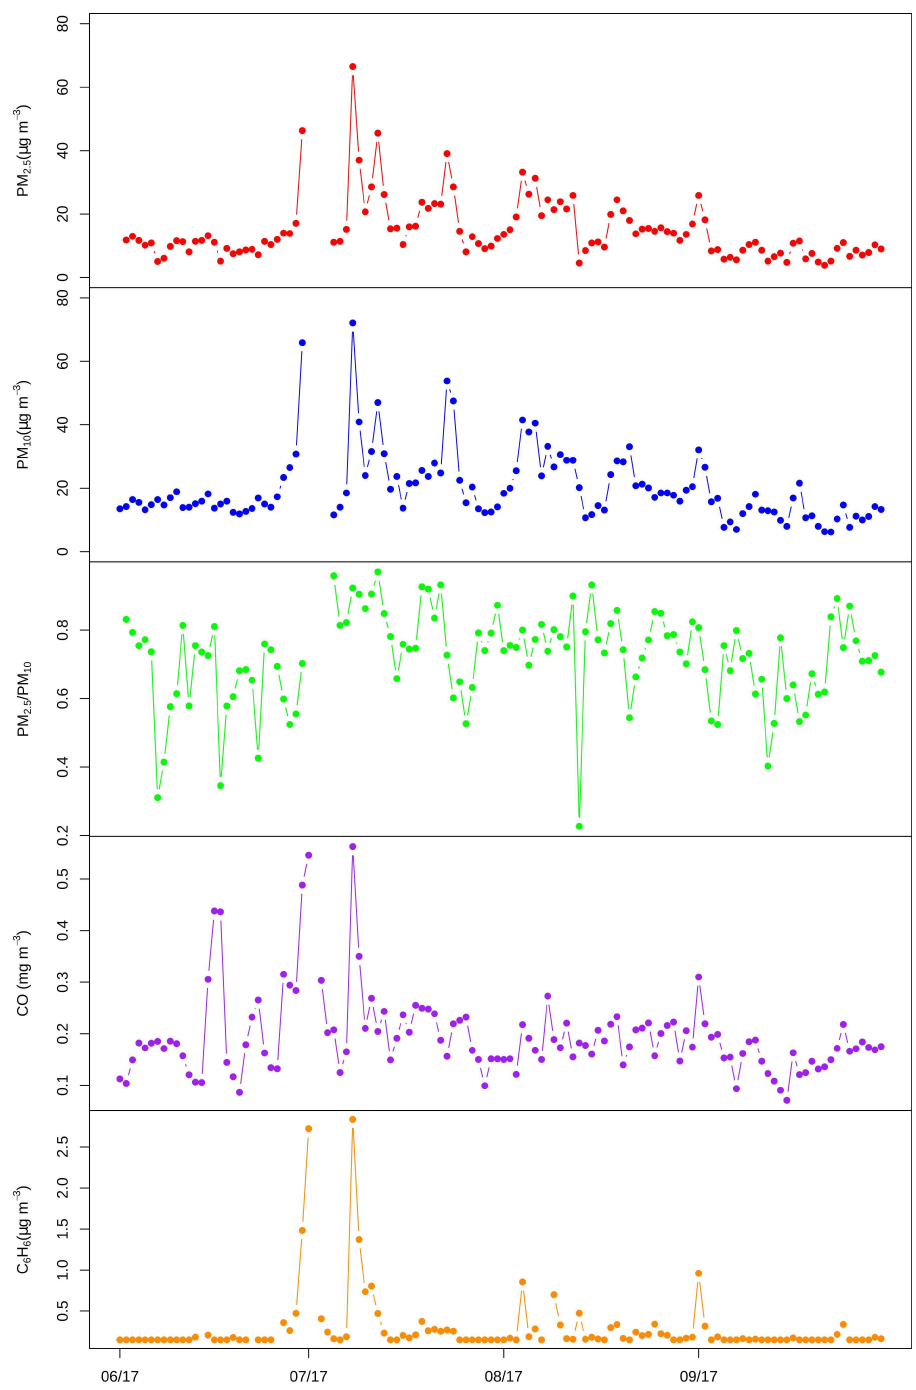
Figure 4. Temporal distribution of PM 2.5 , PM 10 , PM 2.5 / PM 10 , C 6 H 6 and CO recorded at the Mammola station during summer 2017.